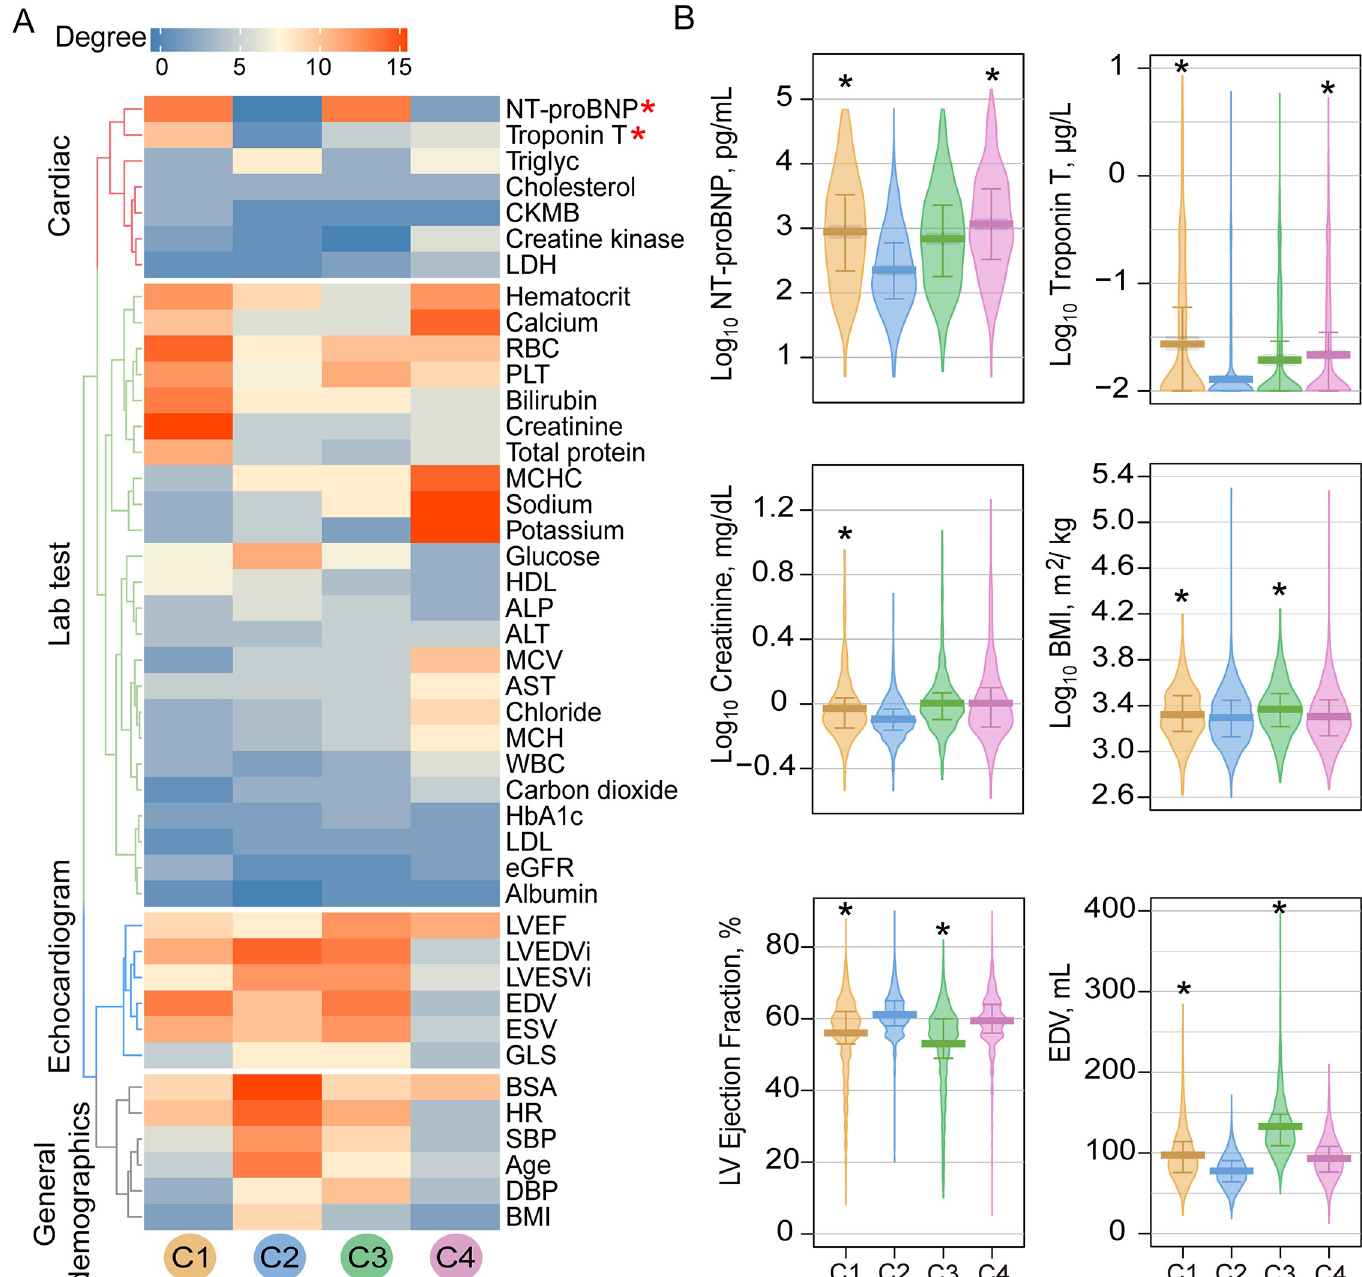
Fig 5. Network and clinical characteristics of variables across patient subgroups. (A) Degree distribution of clinical variables across 4 patient subgroup-specific clinical variable networks. The gradient bar shows the degree (connectivity) range. The 4 colored dendrogram indicated 4 types of clinical variables (consistent with Fig 4A) . The red asterisk highlights the network-identified biomarkers for CTRCD. ( B ) Lab testing values for 6 selected clinical variables across different patient subgroups. The vertical bar denotes the 25% to 75% range, and the thick horizontal lines in each bean plot represent the average value. The black asterisk ( � ) denotes statistically significantly clinical variables in a specific patient subgroup compared to the C2 subgroup (baseline; Fig 2 ). p -value was computed by KS test. All statistical data are provided in S8 Table . BMI, body mass index; CTRCD, cancer therapy–related cardiac dysfunction; EDV, end-diastolic volume; KS, Kolmogorov–Smirnov; LVEF, left ventricular ejection fraction; NT-proBNP, NT-proB-type Natriuretic